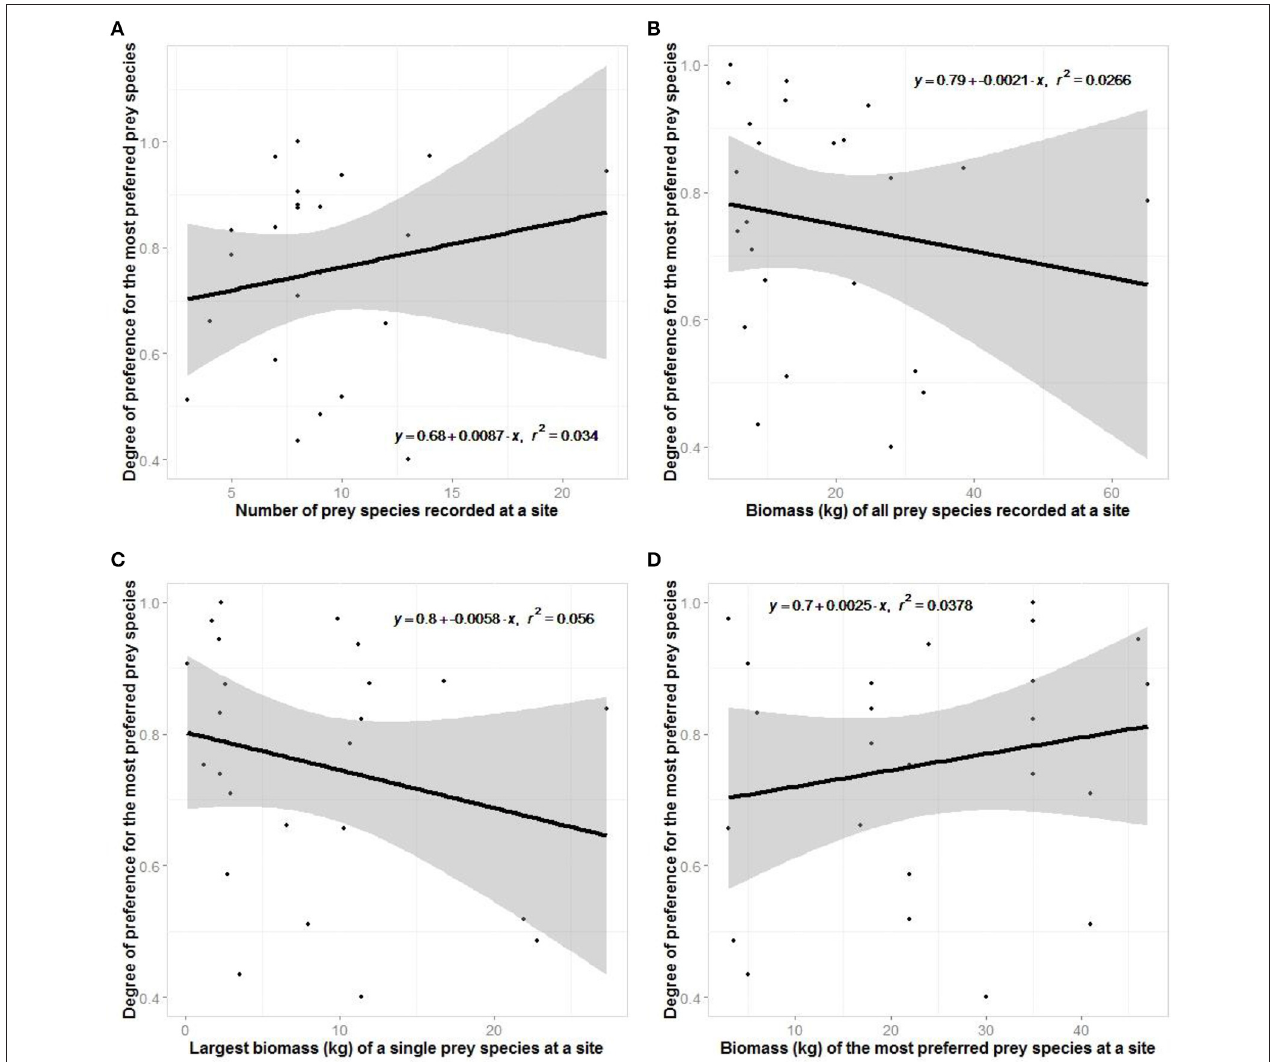
FIGURE 8 | Regression plots testing aspects of optimal foraging theory where the degree of prey preference exhibited at a site is related to (A) the number of species there, (B) the biomass of all prey there, (C) the largest biomass of a species there, and (D) the body mass of the most preferred prey species